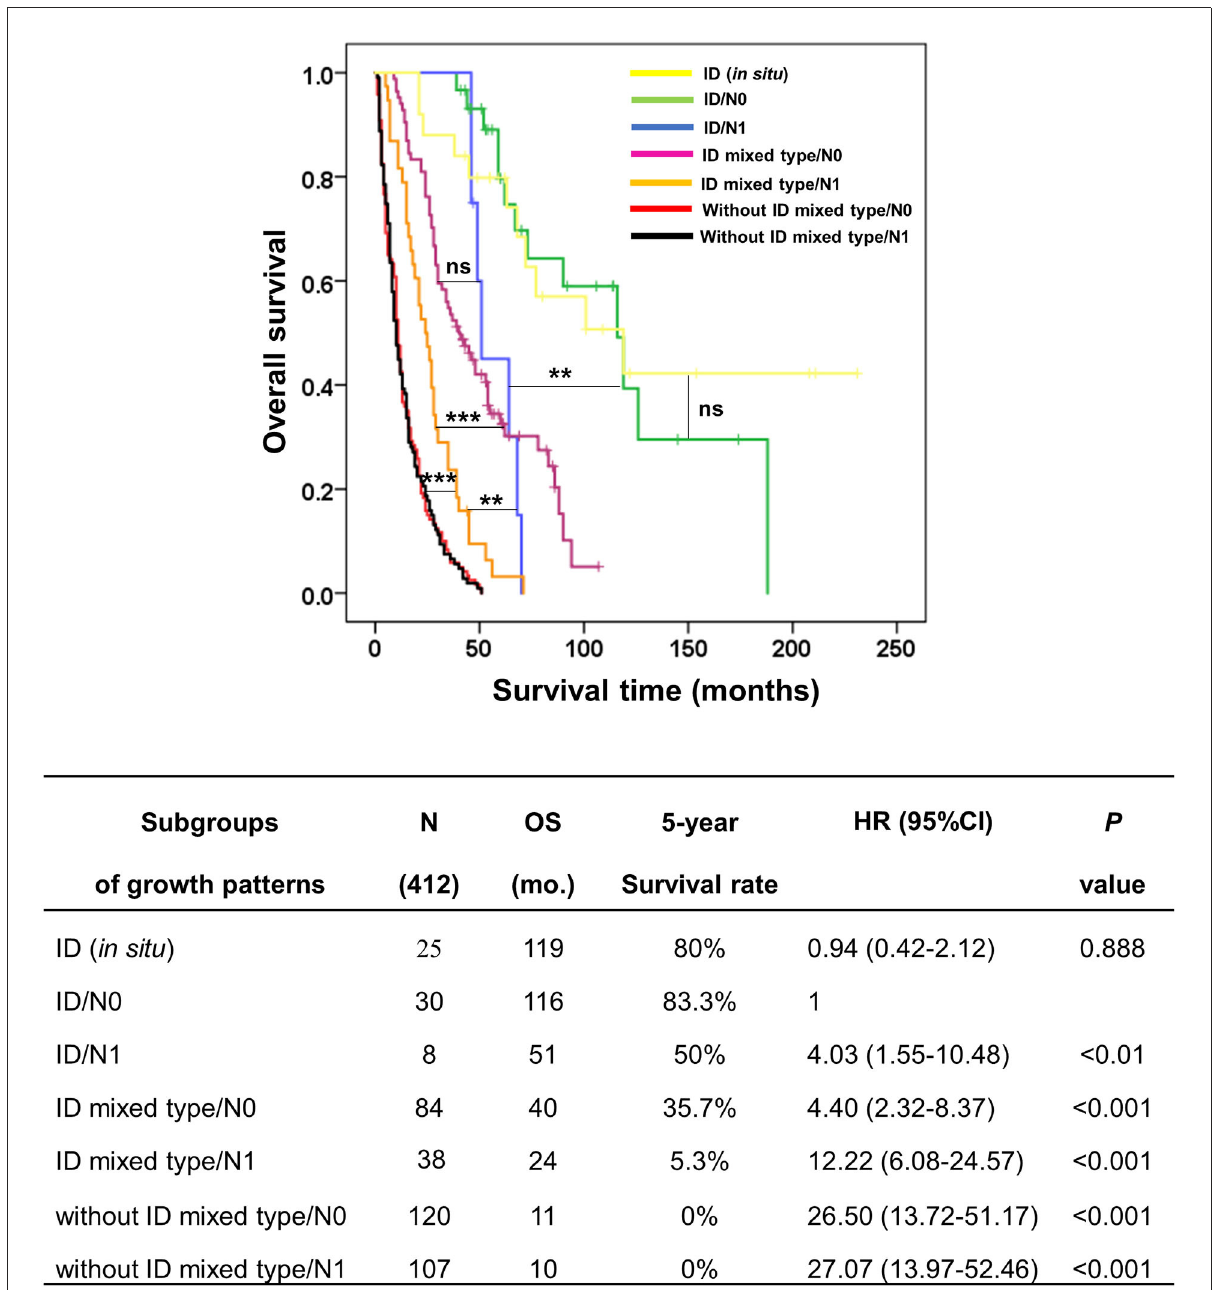
FIGURE5 Kaplan–Meier curve represented the overall survival of subgroup coordinating growth pattern and lymph node status (N0 and N1) in patients with perihilar cholangiocarcinoma. The table represented the outcomes of subgroup analysis, namely, subgroups of growth patterns, number of cases, overall survival, 5-year survival rate, hazard ratio, and p -value. ** p < 0.01, *** p < 0.001, and ns = no statistical